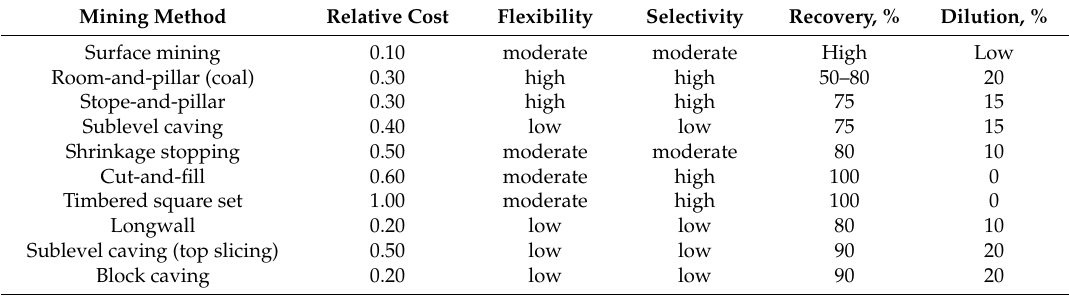
Table 2. Ore recovery and dilution for different mining methods (modified after Darling